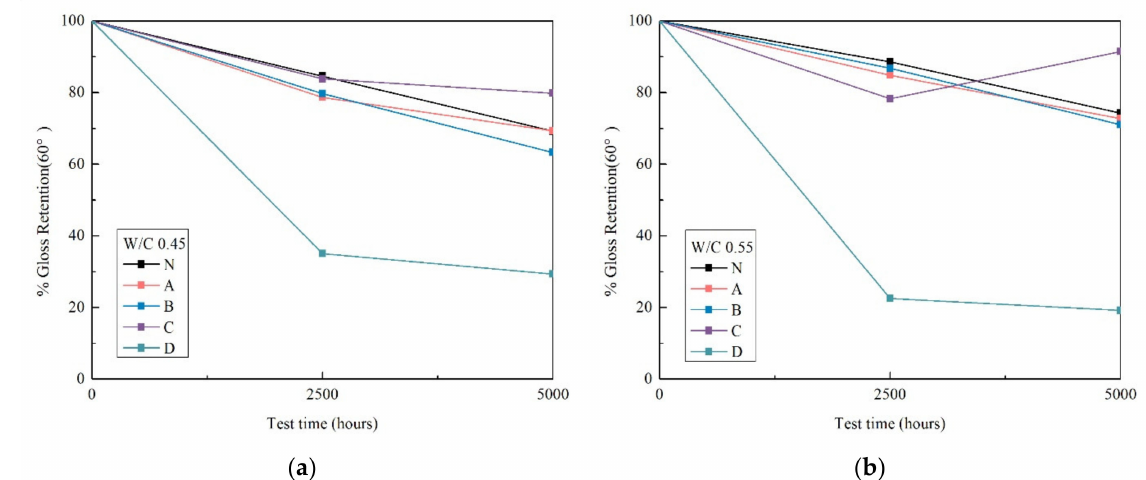
Figure 4. Gloss results of uncoated and coated specimens after 0 h, 2500 h and 5000 h weathering of w/c ratio 0.45 ( a ) and 0.55 ( b